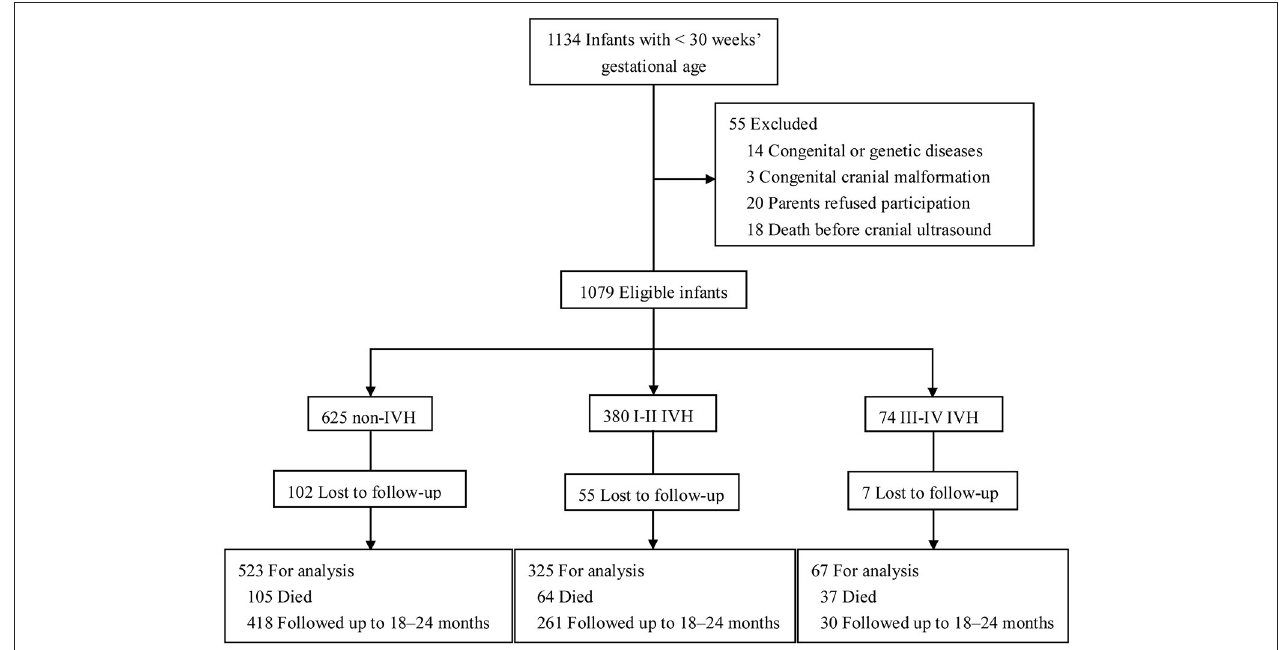
FIGURE 1 | Study flow. Schematic flowchart showing the number of preterm infants in different groups and followed up to 18–24 months of corrected age. Preterm infants were checked with cerebral ultrasound regularly and classified as I-II IVH, III-IV IVH, and non-IVH groups.